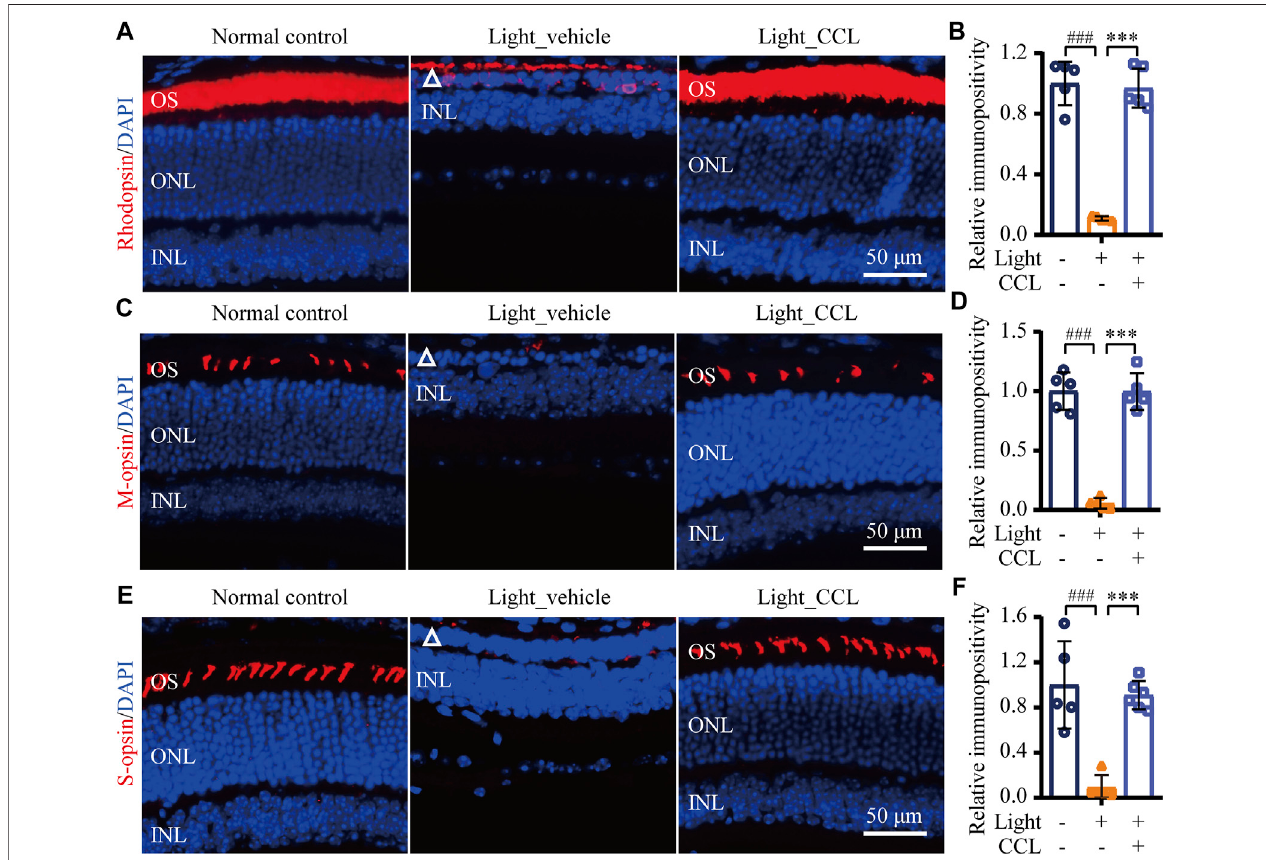
FIGURE5| CCLprotectsagainstlight-inducedablationofrodandconephotoreceptors.IHCwasperformedtoexaminetheexpressionofrhodopsin,M-opsinand S-opsin in the retina (in red). DAPI counterstaining (in blue) was performed to visualize the nuclei. The immunopositivity of rhodopsin, S-opsin and M-opsin in photoreceptor OS was quanti fi ed using ImageJ. (A) Representative micrographs showing the expression of rhodopsin in the retina. (B) The relative fold change in rhodopsinimmunopositivitywasplottedagainstthatfromNormalcontrol. (C) RepresentativemicrographsshowingtheexpressionofS-opsinintheretina. (D) The relativefoldchangeintheimmunopositivityofS-opsinwasplottedagainst thatfromNormalcontrol. (E) Representativemicrographsshowingtheexpression ofM-opsin in the retina. (F) The relative fold change in the immunopositivity of M-opsin was plotted against that from Normal control. White triangle points to damaged ONL. INL, inner nuclear layer; ONL, outer nuclear layer; OS, outer segment. Scale bar, 50 μ m. The data were expressed as mean ± SD (n = 5 per group). ### Compared to Normal control, p < 0.001; *** compared to Light_vehicle, p <